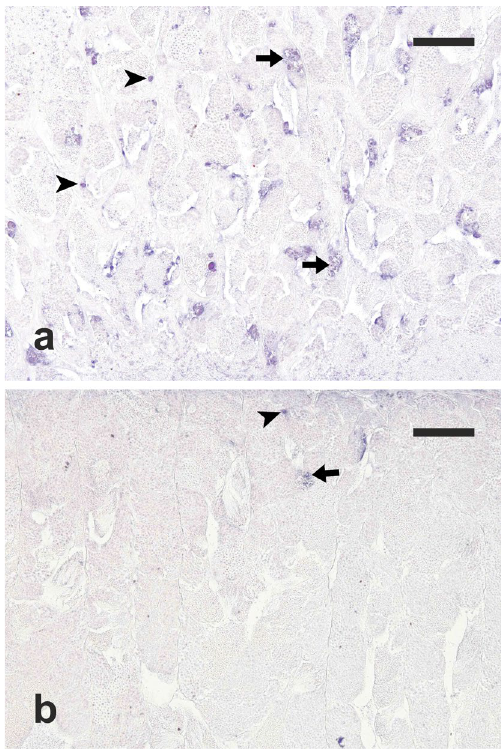
Figure 7. Micrographs of testis sections from ( a ) a juvenile meagre treated with saline solution for 6 weeks (CONTROL 6 group) and ( b ) a juvenile meagre treated with rFsh for 6 weeks (TREATED group), stained with the terminal deoxynucleotidyl transferase-mediated 2 ′ -deoxyuridine 5 ′ -triphosphate nick end labeling (TUNEL) method, with apoptotic cells appearing as dark blue dots. Magnification bars = 100 μm. Arrow = TUNEL– positive spermatogonial cyst; arrowhead = TUNEL–positive single type A spermatogonium.